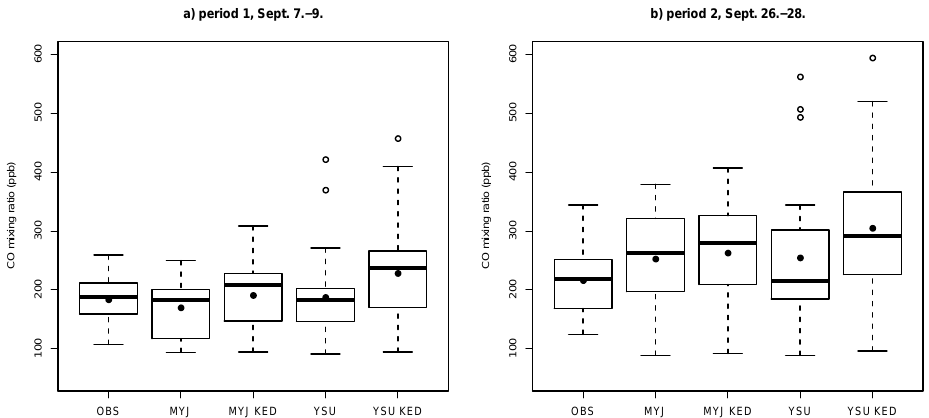
Figure 11. Comparison of observed (OBS) and simulated night-time CO concentrations using the STILT/MYJ simulation (MYJ), the STILT/MYJ simulation with optimized MHs (MYJ KED) and similarly the STILT/YSU simulations (YSU, YSU KED) during period 1 (a) and 2 (b) . Boxes denote the central 50% of the data, whiskers are at ± 1.5 times the inter-quantile range and outliers are shown as open circles. Black line within boxes indicate the median value. Filled points show the mean values.